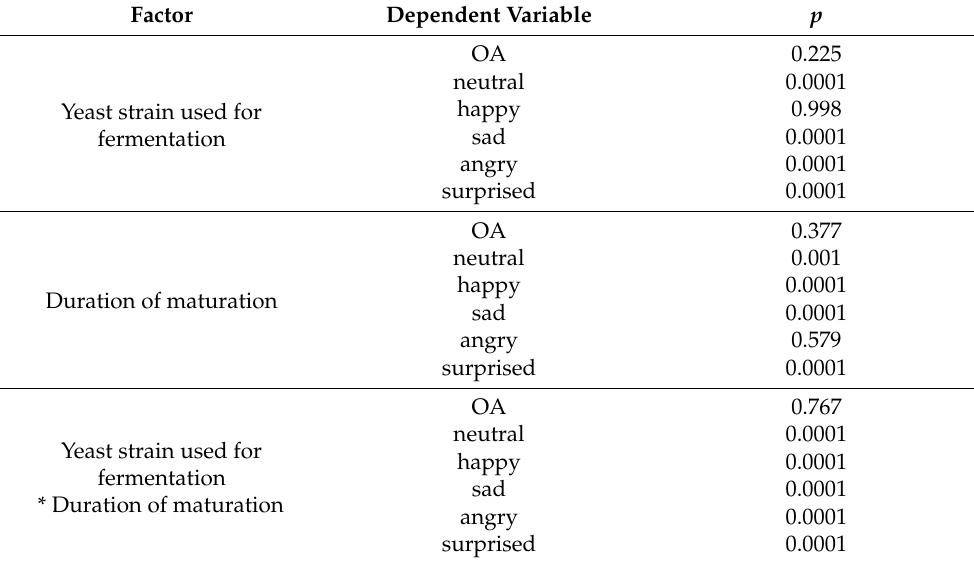
Table 3. Influence of the analysed factors and their interaction on overall acceptability and emotions induced for consumers by beer